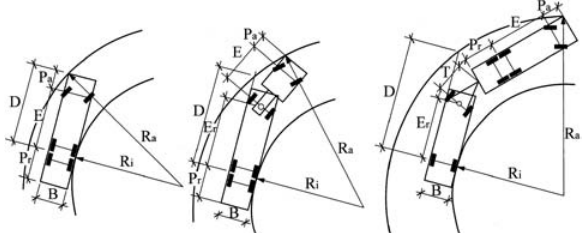
fig. 6. Reduced wheel base D for different vehicle type